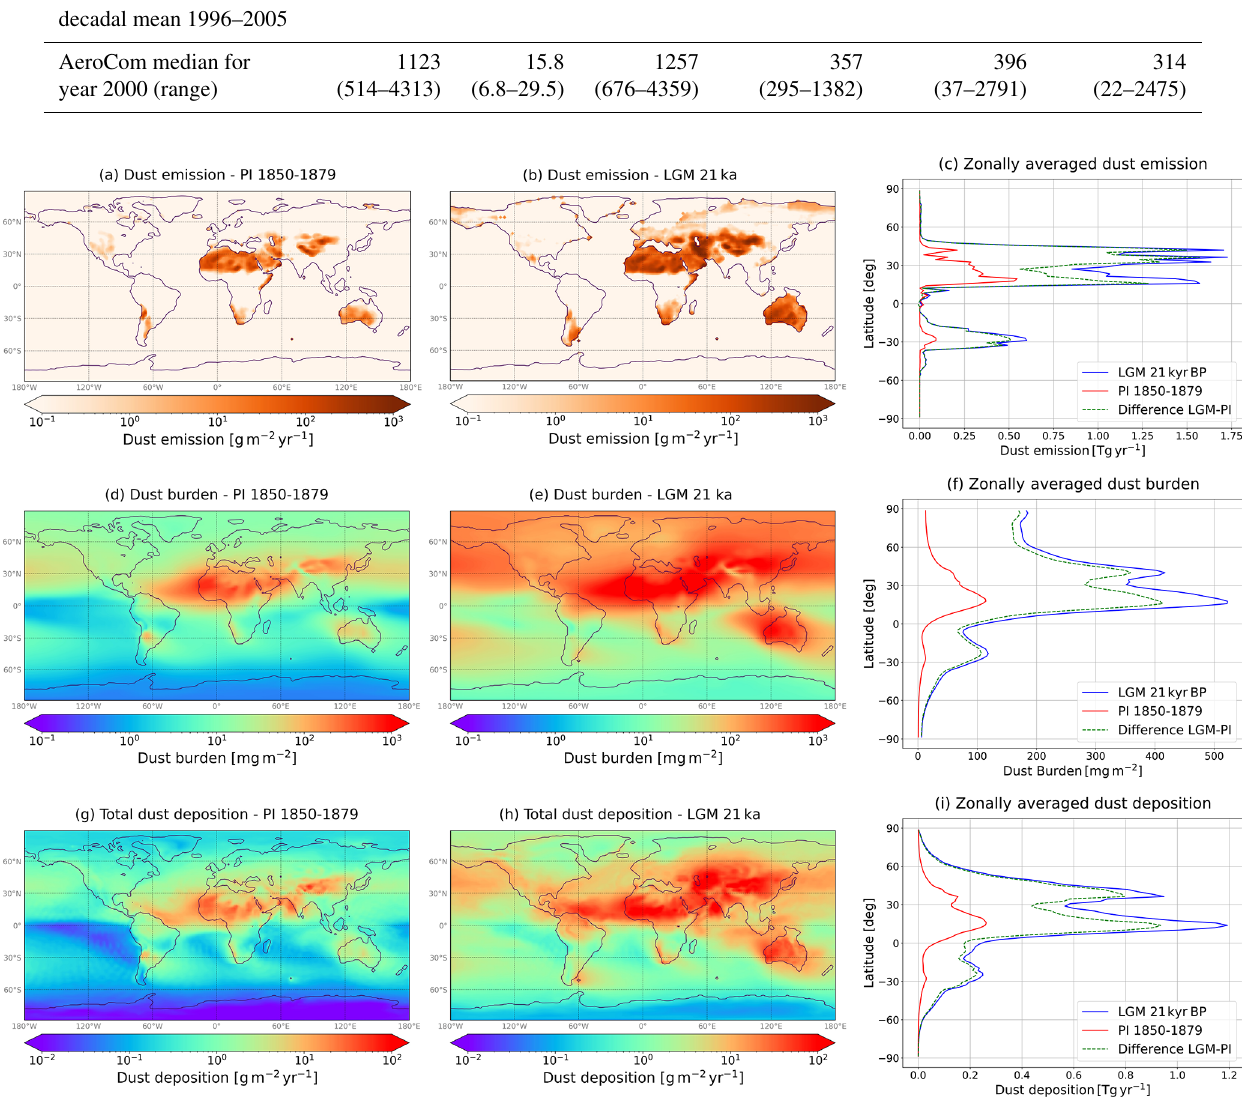
Figure 1. Global maps showing the dust emission, burden and deposition for PI (a, d, g) and LGM climate conditions (b, e, h) . Additionally, zonally averaged graphs are shown for all quantities (c, f, i)